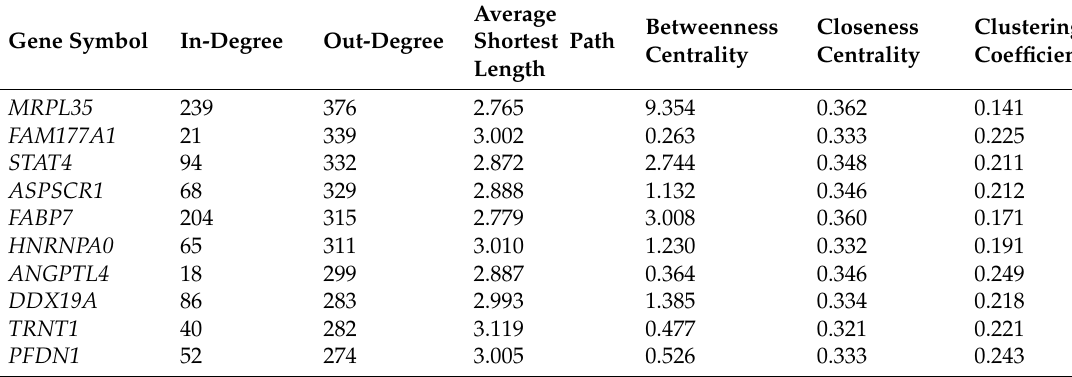
Table 4. Top 10 hub genes according to the out-degree centrality from our proposed